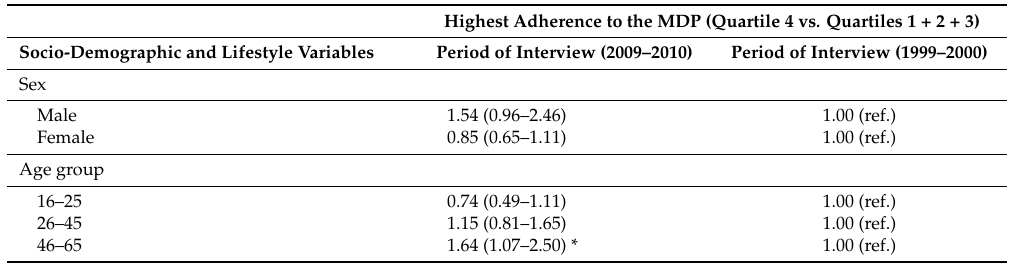
Table 3. Changes (2000–2010) in highest adherent individuals to the MDP (quartile 4) according to selected socio-demographic and lifestyle